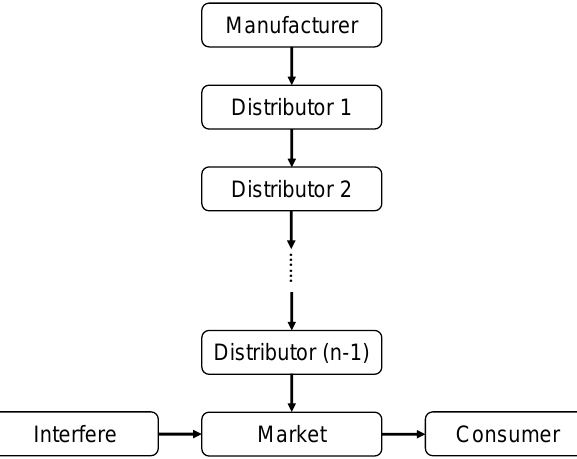
Figure 1. The illustration of complex dynamic supply